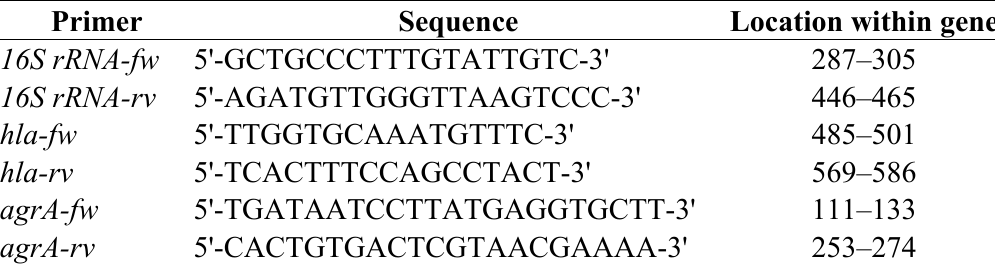
Table 3. Primers used in real-time